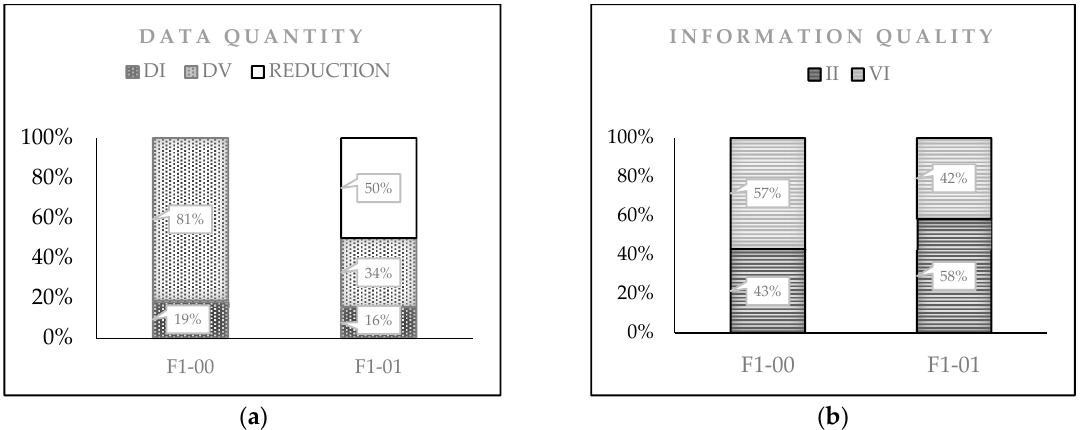
Figure 2 . ( a ) Data quantification comparison and ( b ) quality of produced information for the two forms. Left bar of both graphics: F1–00. Right bar of both graphics: F1–01.